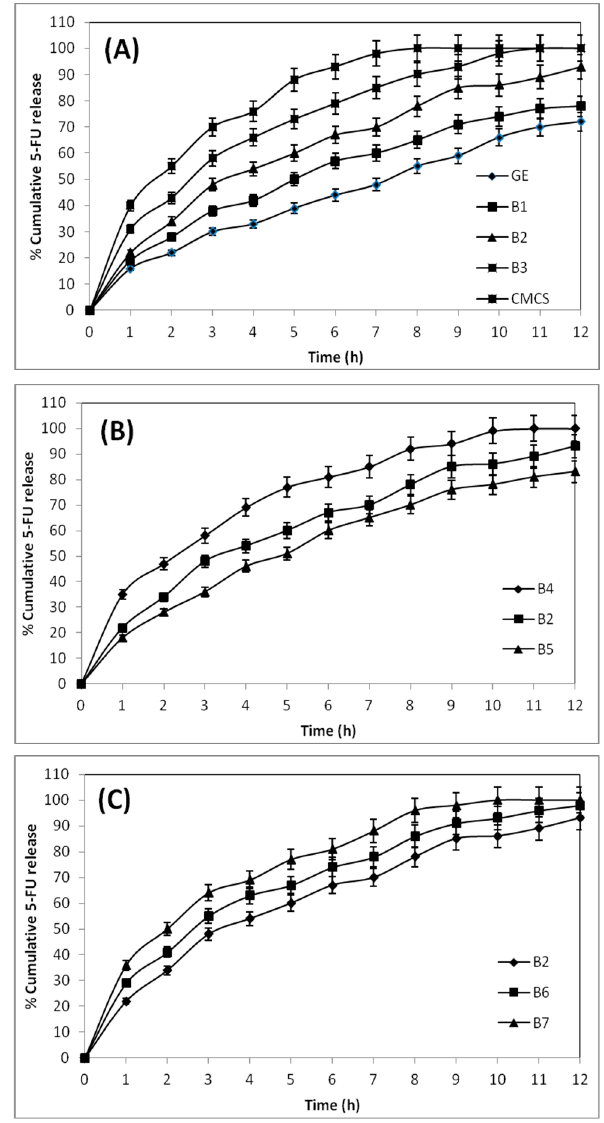
Figure 6. Effect of ( A ) blend composition; ( B ) amount of cross-linking agent, and ( C ) initial drug loading on in vitro 5-FU release from blend hydrogel microspheres in gastric (pH 1.2) and intestinal (pH 7.4) conditions at 37 °C.